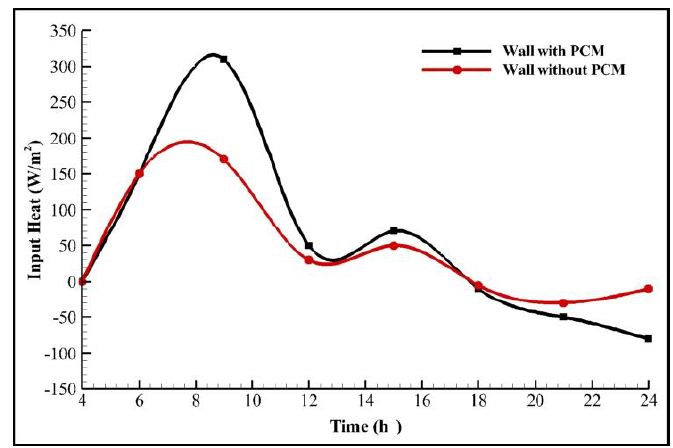
Figure 6. Temperature variation of the test room with and without PCM (REF) at a height of 1.5 m in the month of January.